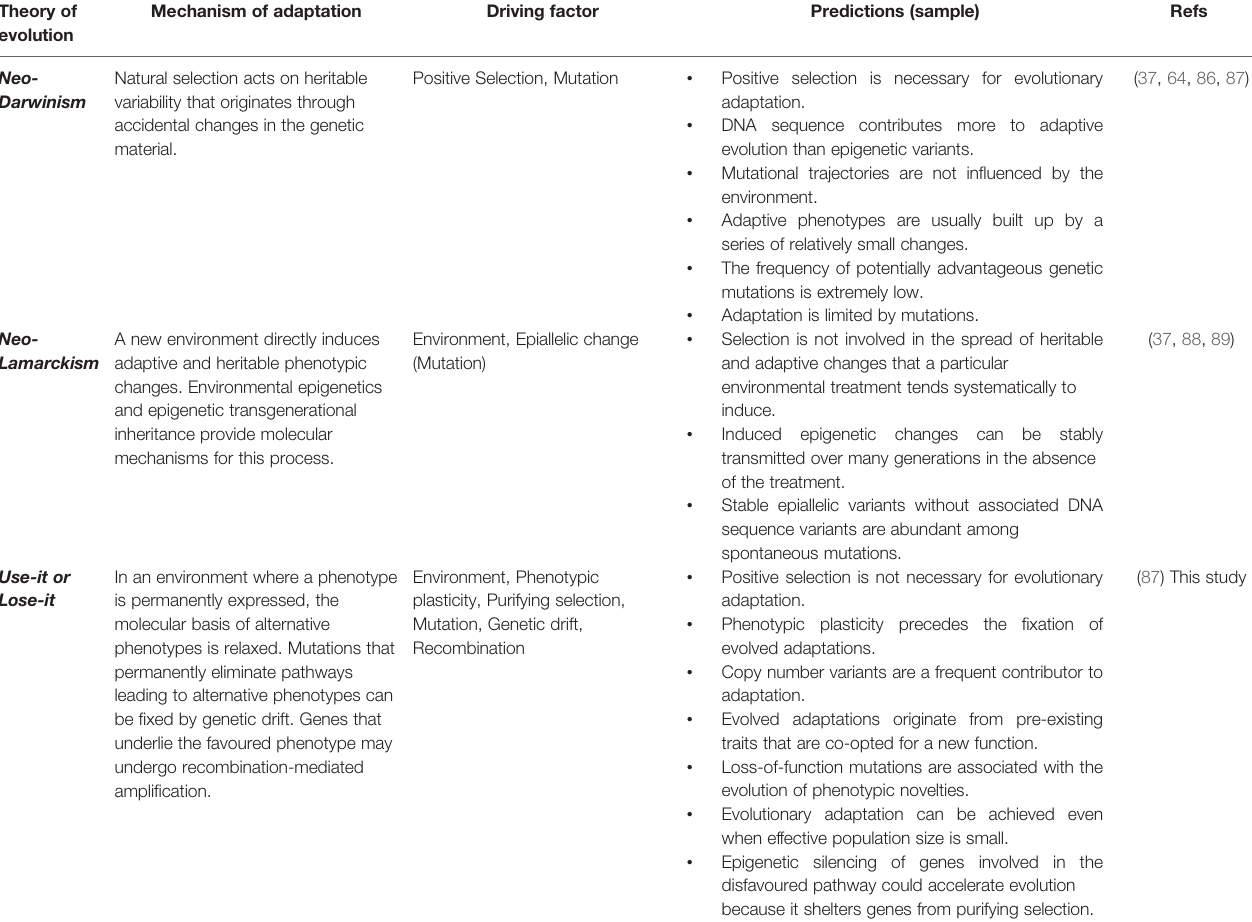
TABLE 1 | Putative mechanisms responsible for the origin of evolved